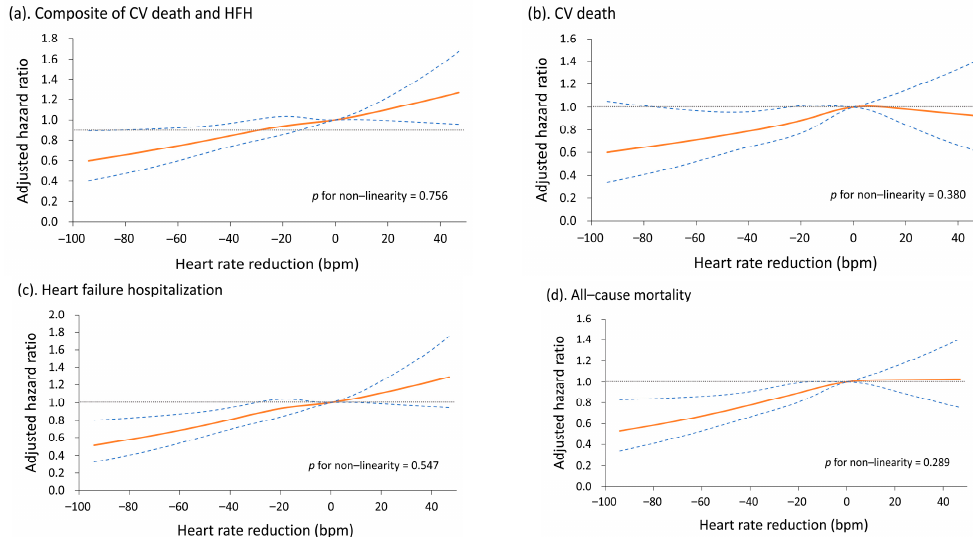
Figure 3. Relationship between changes in heart rate from discharge to 3-month screening period and risk of the composite outcome of cardiovascular death and HHF ( a ), cardiovascular death ( b ), HHF ( c ), and all-cause mortality ( d ) in patients with heart failure with reduced ejection fraction. HHF, hospitalization for heart failure; CV, cardiovascular.